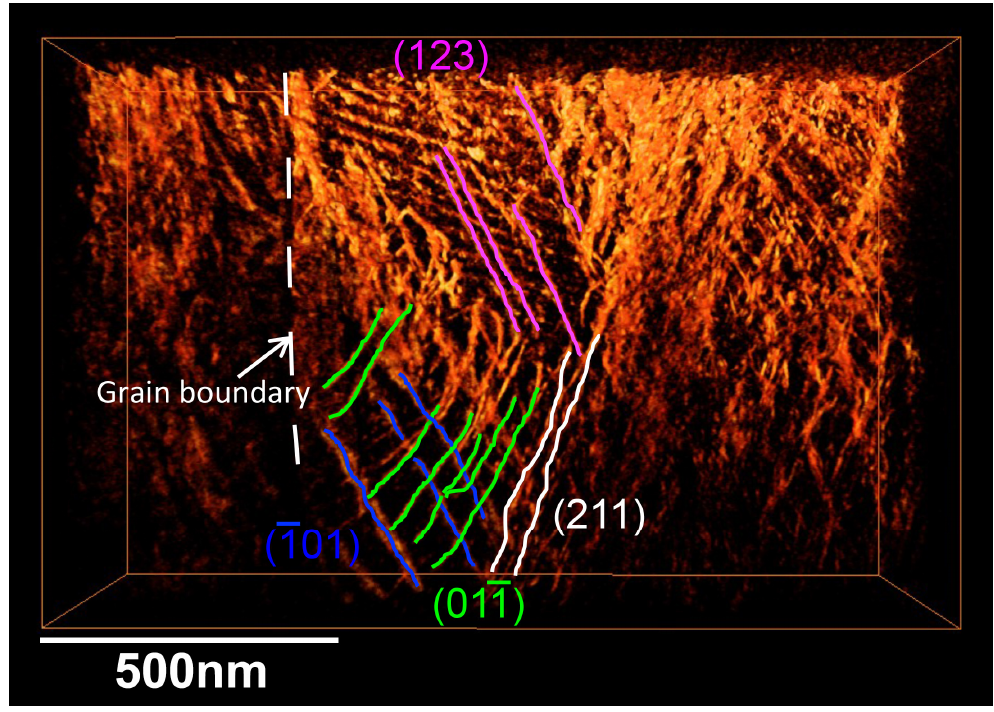
Figure 6. A result of slip plane analyses: dislocations on different slip planes are marked by different